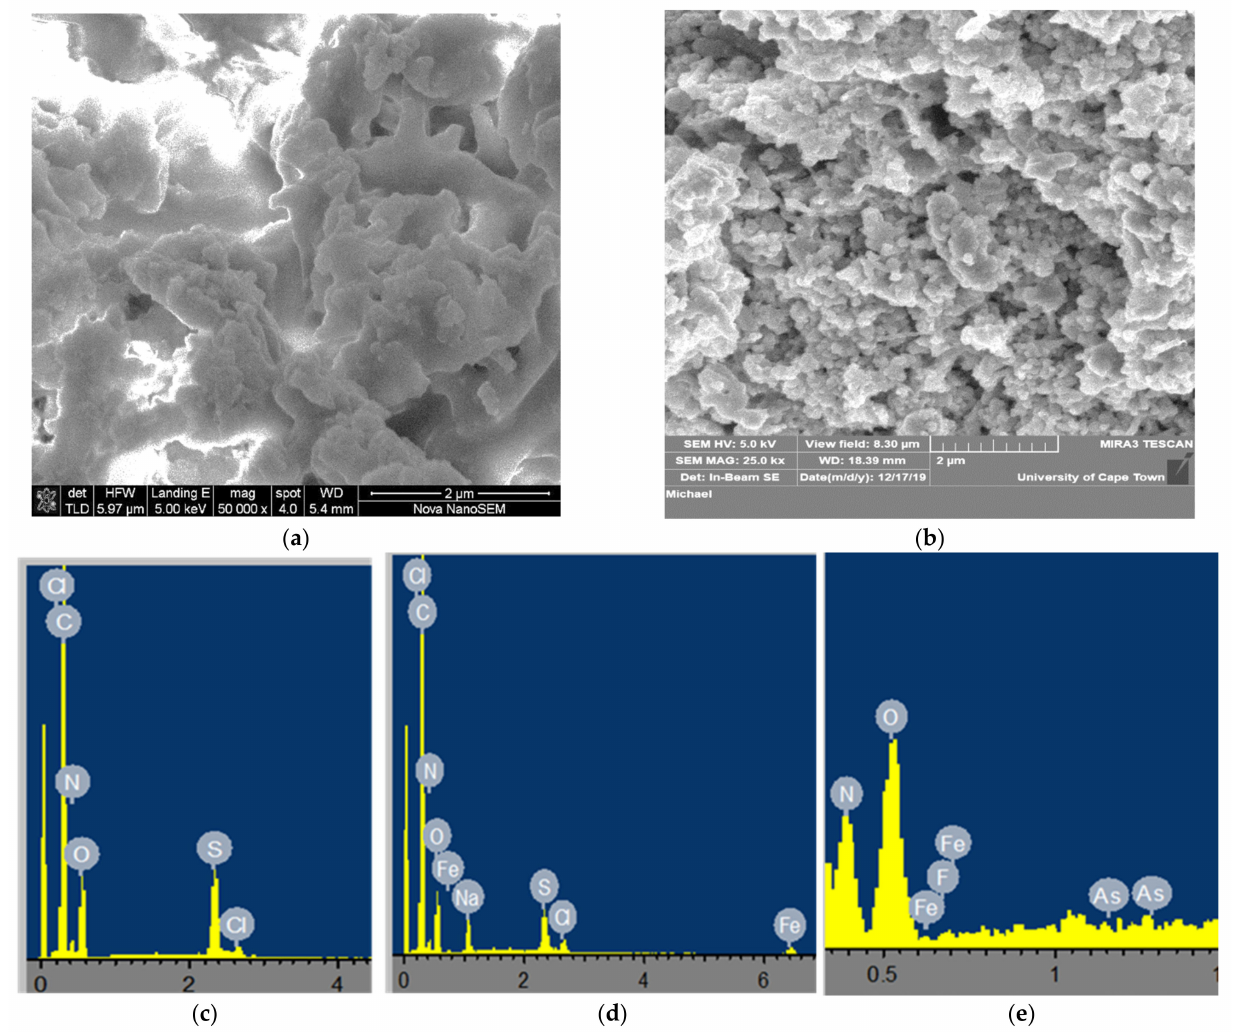
Figure 3. SEM-EDS results: ( a , b ) SEM images of bare pPD and Fe-pPD; ( c ) EDS spectra of bare pPD; ( d ) Fe-pPD EDS spectra; ( e ) EDS spectra of the co-adsorbed As and F ions on the Fe-pPD